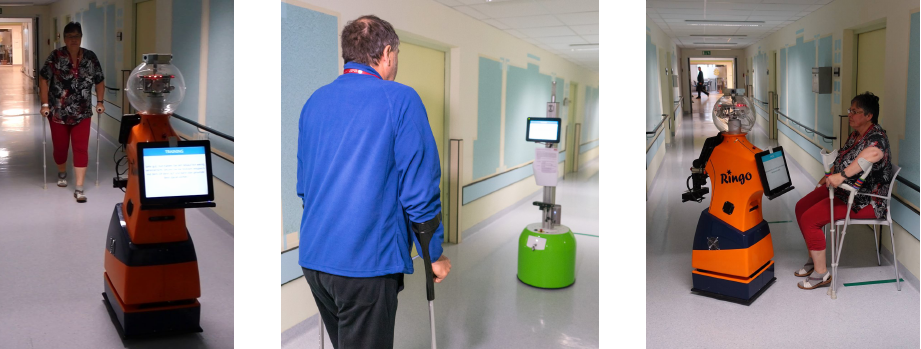
Figure 1. Patients during SAR-based self-training, where training robots drive in front of the patients and provide motivational and corrective feedback on their gait behavior ( left , middle ). Patients can pause the training at resting places ( right